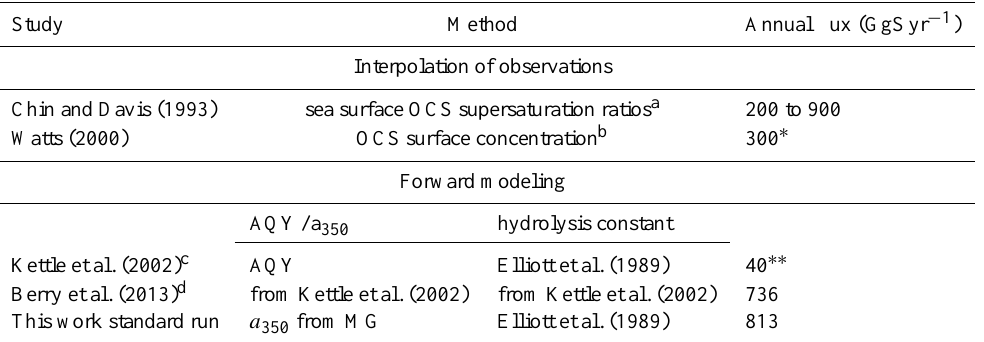
Table 2. Yearly global OCS flux emitted from ocean to the atmosphere (in GgSyr − 1 ) depending on the different parameterizations presented in previous work and in this work. F: a 350 parameterization presented in this work; MG: a 350 parameterization presented in Morel and Gentili (2009); P: a 350 parameterization presented in Preiswerk and Najjar (2000).